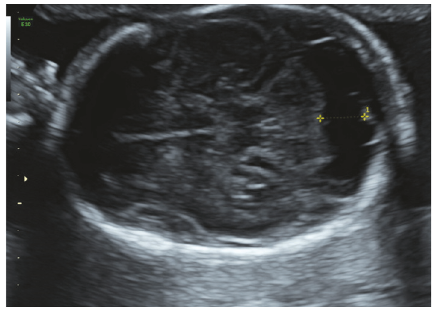
Figure 3: Enlargement of the cisterna